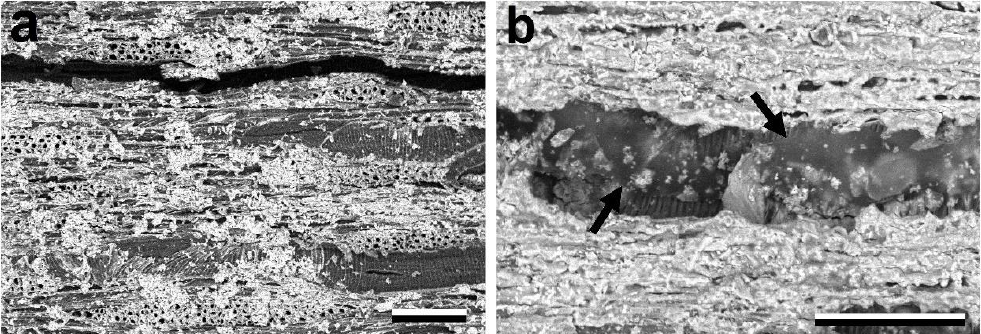
Figure 4. ( a ) SEM micrograph of a mock-up with no agarose residues; ( b ) SEM micrograph of mock-up where agarose residues (arrowed) are observed in a vessel lumen. Scale bars = 100 μm.